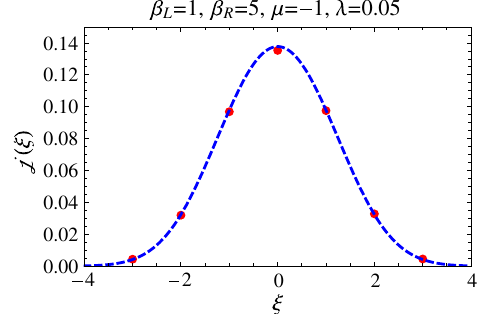
FIG. 6. Energy current in the Lieb-Liniger model for low temperatures, small coupling, and negative chemical potential (circles). The dashed curve represents the current [Eq. (46)] for the same temperatures and chemical potential.